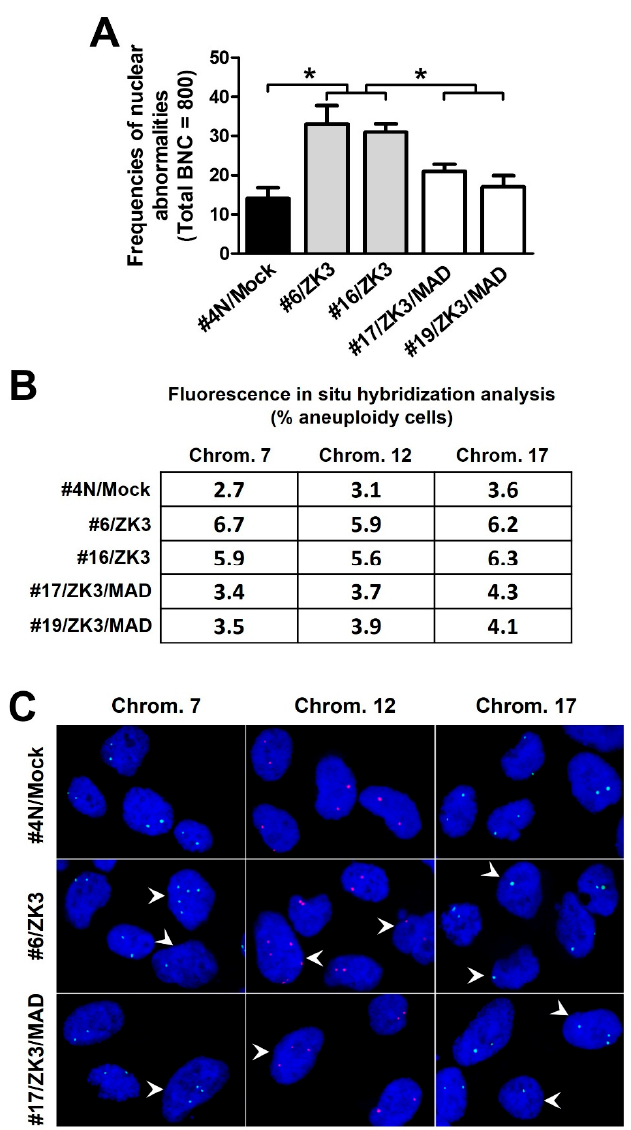
interphase nuclei. The proportion of #4N cells with signals deviating from the modal values ranged from 2.7% (chromosome 7) to 3.6% (chromosome 17); however, the proportion of HCT116 cells with ZKSCAN3 overexpression ranged from 5.9% to 6.7% (#6/ZK3), and from 5.6% to 6.3% (#16/ZK3) (Figure 6B,C).